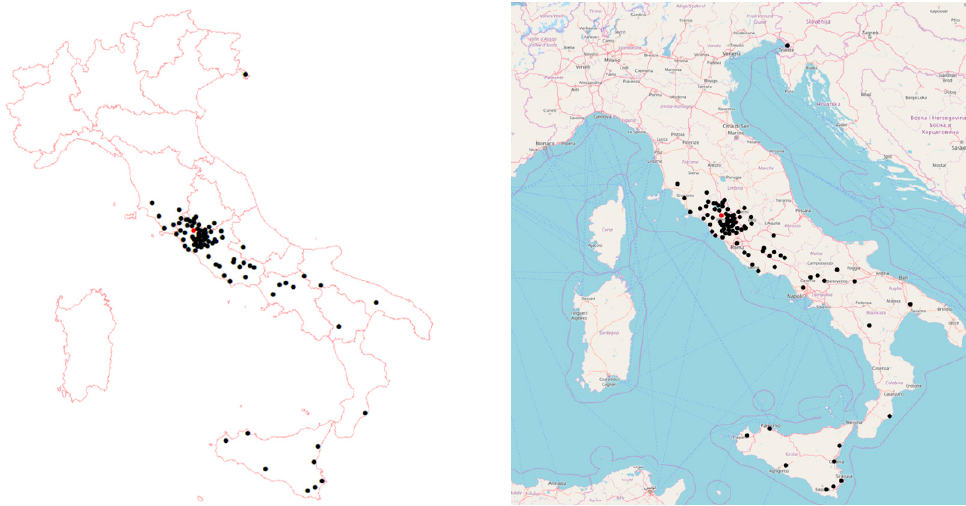
Figure 1. Age groups of questionnaire participants (left) and their current position at the Tuscia University (right).